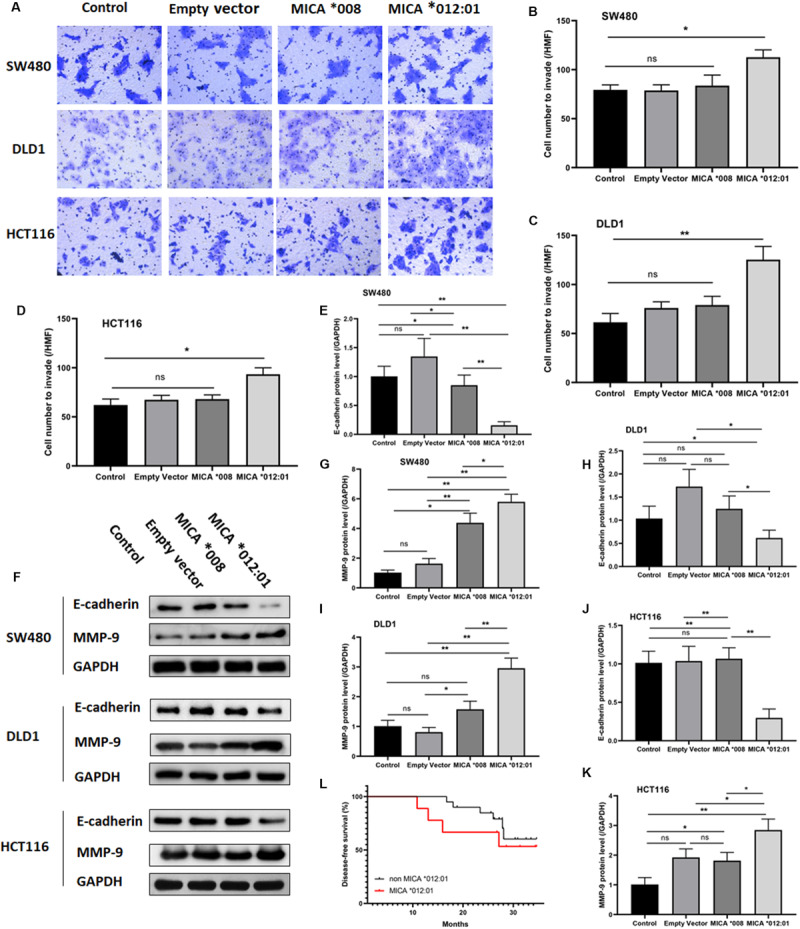
The invasive and metastatic properties of KRAS mutated CRC cell lines transfected with MICA *012:01 or MICA *008 allele. The invasive capability of MICA allele overexpressing CRC cell clines was evaluated by transwell assay in (A) SW480 cells, DLD cells, and HCT116 cells. HMF, high magnification field (400 fold) with corresponding histograms (B–D). ns, no significance; *p < 0.05; **p < 0.01. (E) Relative amounts of total MMP-9 and E-cadherin protein levels were analyzed by Western blotting experiments. Representative blots are shown. (F–K) Corresponding histograms of the results are shown. ns, no significance; *p < 0.05; **p < 0.01. (L) The disease-free survival curve of MICA *012:01 and non-MICA *012:01 alleles in CRC patients carrying KRAS codon 12 mutation. Control, untransfected cells; Empty vector, cells transfected with pEGFP-C3 plasmid vector; MICA *008, cells transfected with pEGFP-MICA *008 recombination vector; MICA *012:01, cells transfected with pEGFP-MICA *012:01 recombination vector.